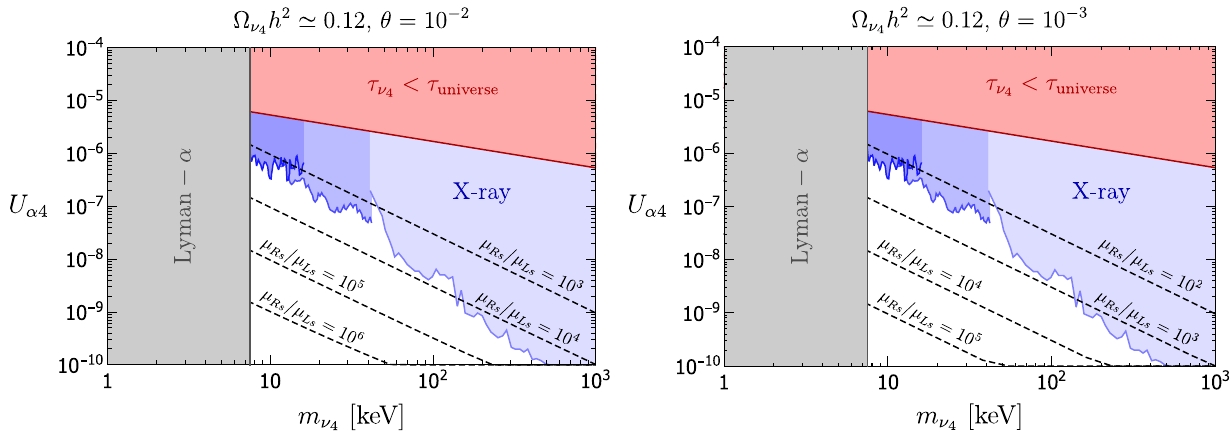
matter. The grey region corresponds to Lyman- α constraints from the matter power spectrum on light free-streaming dark matter particles, estimated from [57]. The red region represents the parameter space for which the dark matter lifetime is shorter than the age of the Uni- verse, estimated using Eq.(3.9). In this figure we fixed m N = 150 GeV, = m = 50 GeV, v = 200 GeV, m ϕ (cid:7) m v = 1 MeV, m ϕ A N , 1 2 2 1 μ = 10 RR